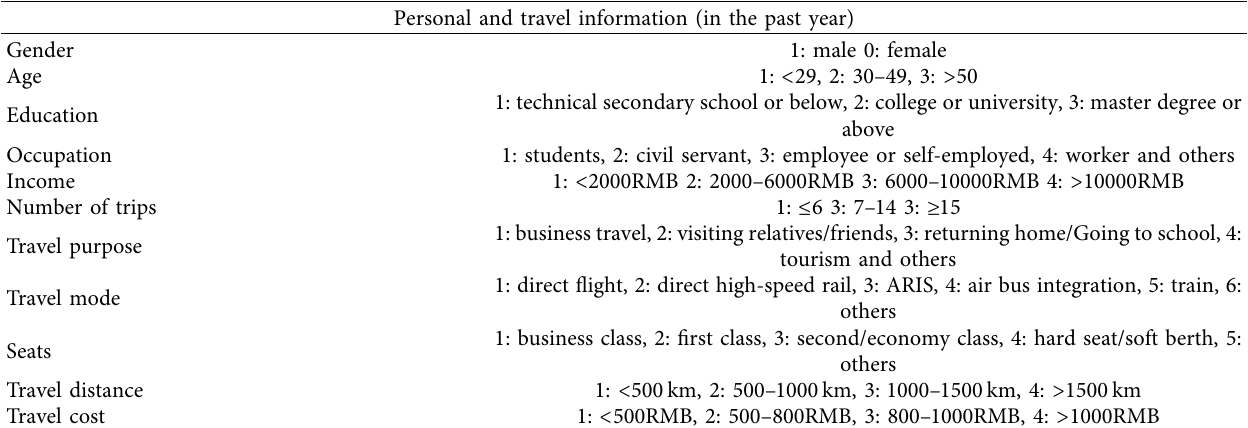
Table 1: Personal and travel